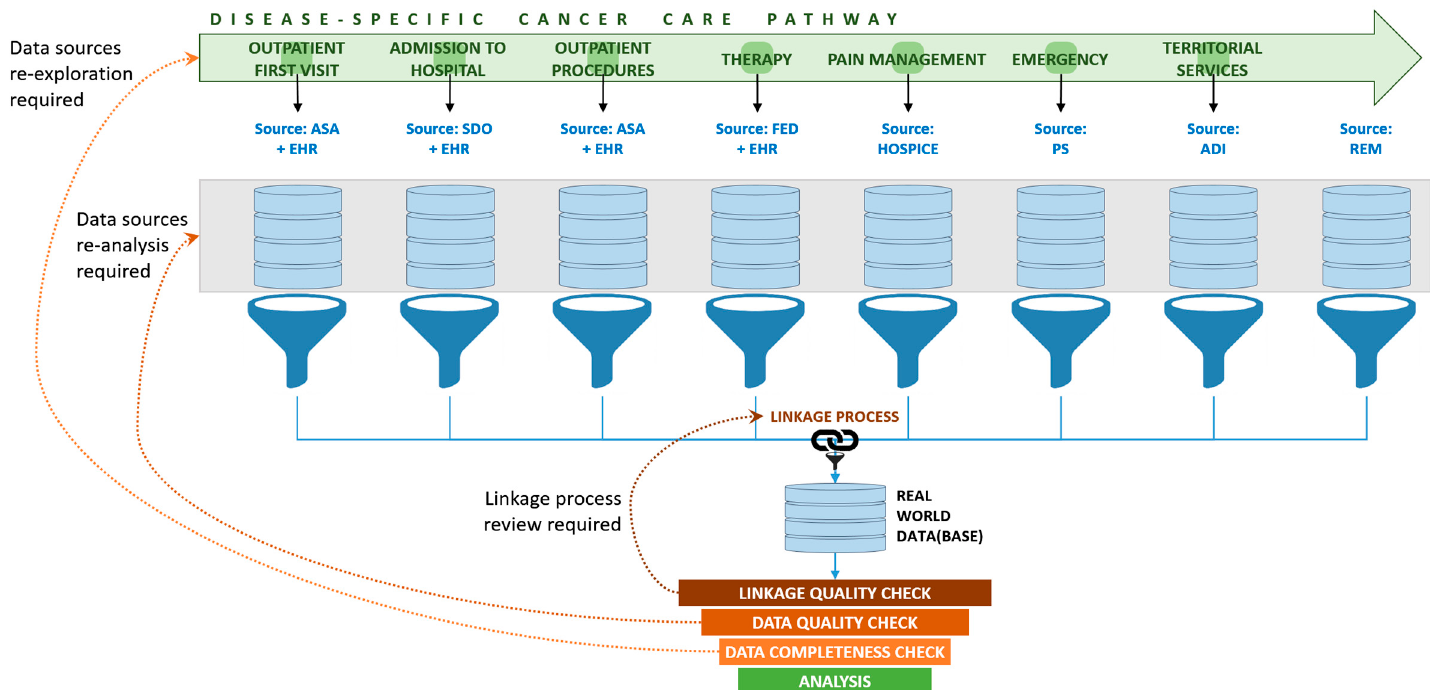
Figure 1. Schematic diagram of the extract / transform / load (ETL) process for acquiring cross-sectional information from multiple sources. Except for the Hospice Database, the data sources are indicated with the standard abbreviation in Italian: ASA indicates Outpatient Specialist Assistance Database; EHR indicates Electronic Health Record, that is, the electronic clinical data record archive at the Istituto Scientifico Romagnolo per lo Studio e la Cura dei Tumori (IRST) of Meldola; SDO indicates Hospital Discharge Database; FED indicates Drugs Database; PS indicates Emergency Database; ADI indicates Home Care Database; REM indicates Mortality Registry.